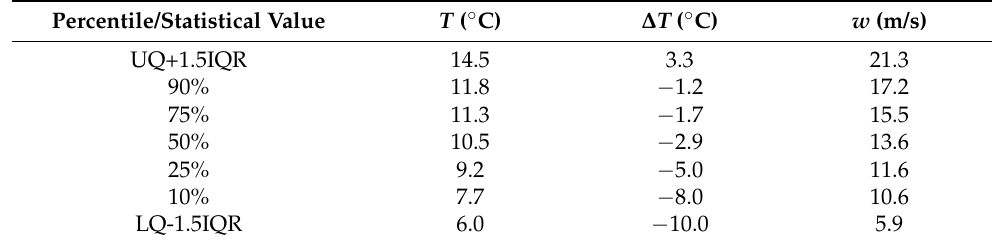
Figure 7. Cumulative distribution of cold surge indicators of all cold events: ( a ) 𝑇 , ( b ) ∆𝑇 and ( c ) 𝑤 . The corresponding values of the 50th (50th), 25th (75th) and 10th (90th) percentiles for 𝑇 , ∆𝑇 , ( 𝑤 ) are marked. Table 5. Key percentiles and statistical values of the three cold surge